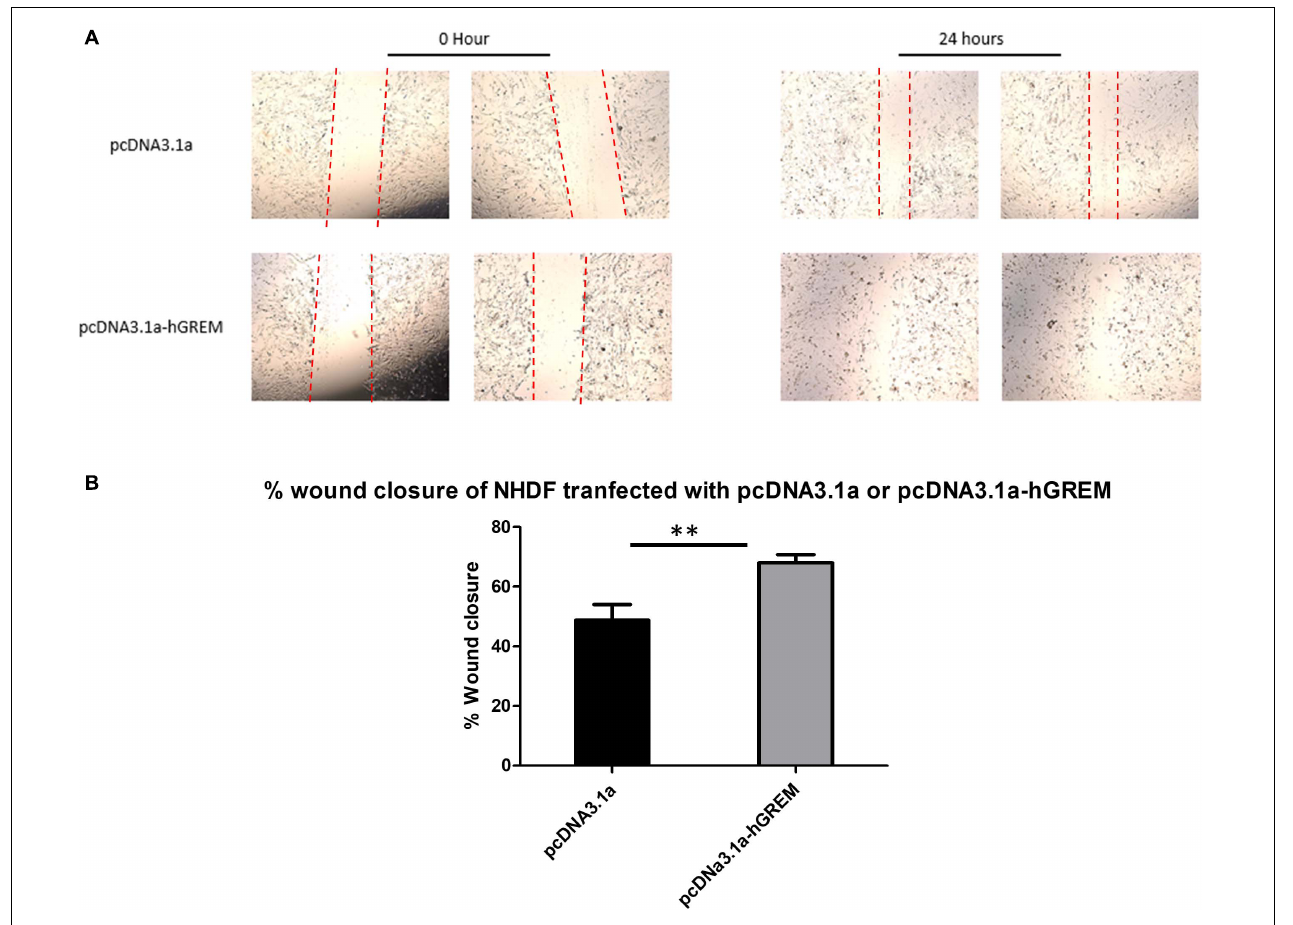
FIGURE 3 | Gremlin-1 increased migration in normal healthy dermal fibroblasts. Normal human dermal fibroblasts were transfected with the plasmid construct pcDNA3.1a with or without the human Gremlin-1 insert. Cells were seeded at high confluency and a scratch assay performed. (A) Representative images. (B) Images were then quantified in Image J software and wound closure obtained as a percentage of the initial wound. Gremlin-1 increased wound closure in these cells at 24 h time point ( n = 3, Student’s t -test, ∗∗ P ≤